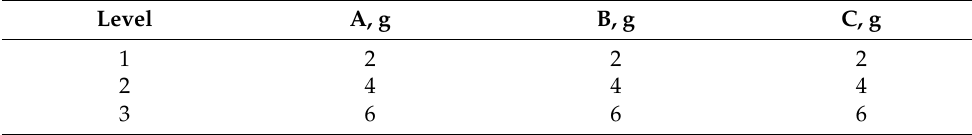
Table 3. L9 (33) factor level table of orthogonal